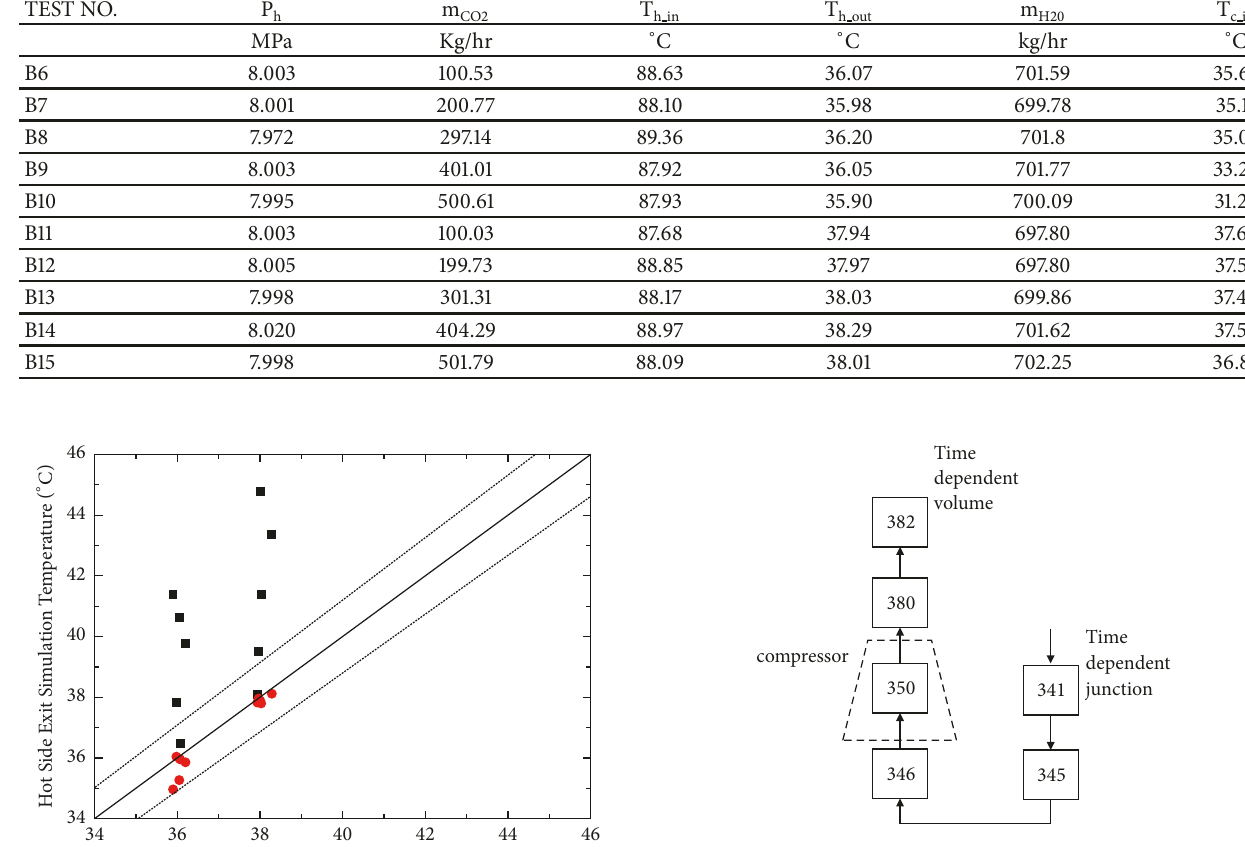
Figure 10: Nodalization of the recompressing